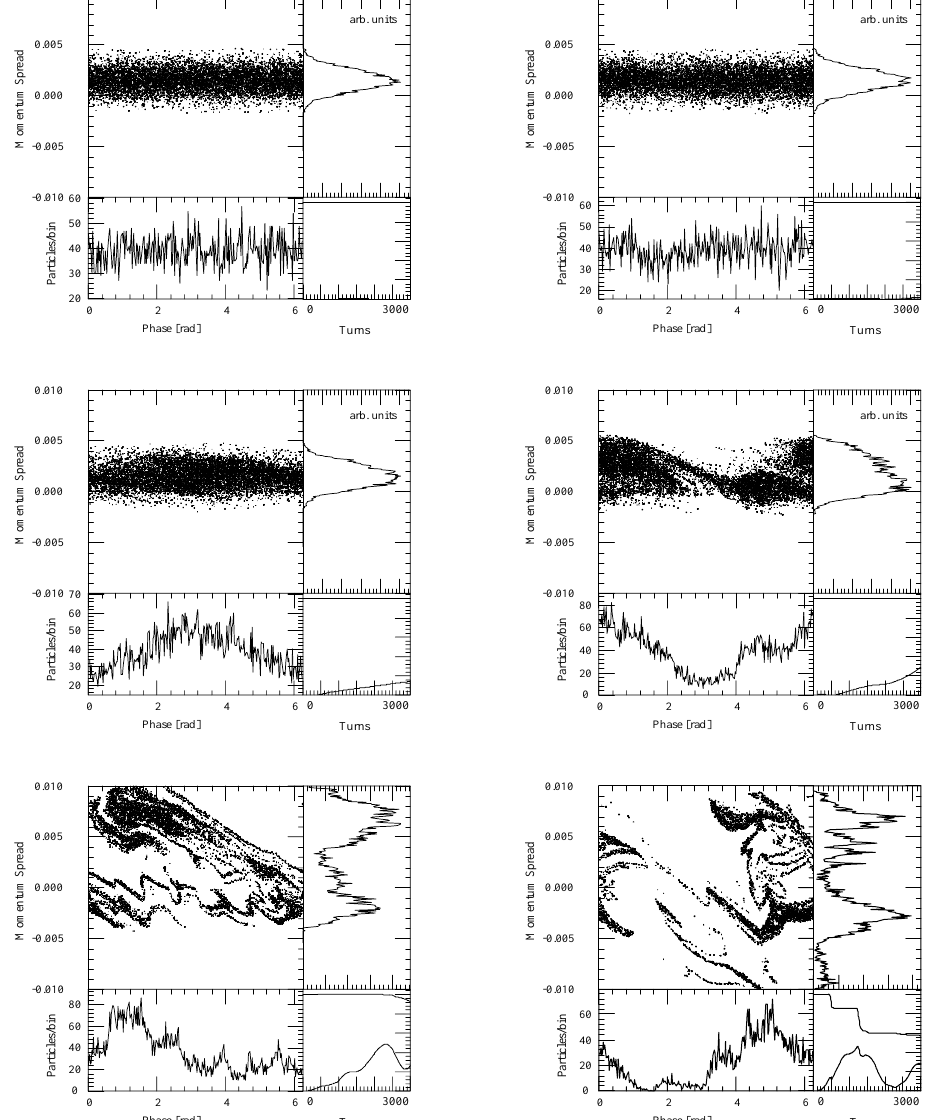
FIG. 7. The individual pictures show the longitudinal phase space after 3000 turns with 10 000 particles with wake and feedback. The feedback uses 128 kicks (cid:3) turn (top left), 64 kicks (cid:3) turn (to the right), down to 4 kicks (cid:3) turn (bottom right) in steps of the power of 2. Compare to the corresponding system without feedback in Fig.